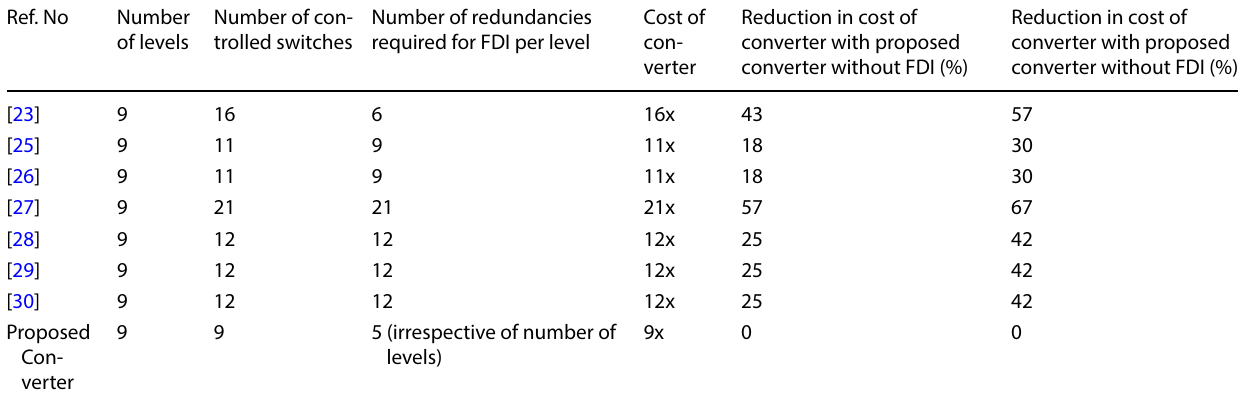
Table 7 Comparative analysis of MLI with proposed MLI Ref.